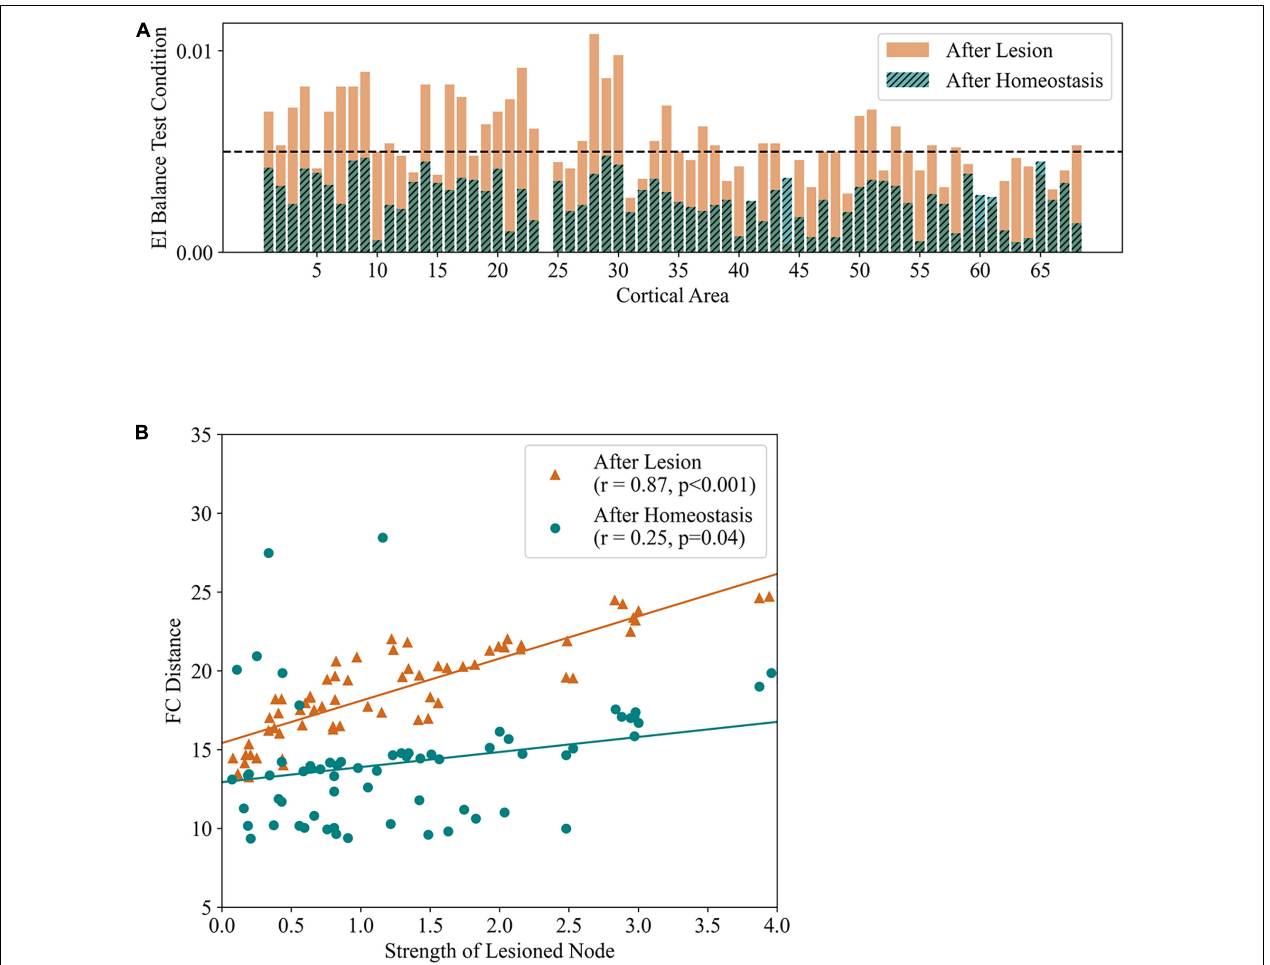
FIGURE 5 | EI homeostasis and recovery of FC cooccur in large-scale computational models of stroke. Results from the application of focal structural lesions in a large-scale model of the cortex with local EI homeostasis. (A) EI balance test condition measured immediately after lesion in the left precuneus and after homeostatic adaptation. Areas with values lower than 0.005 are considered balanced. It can be observed that EI balance is lost across the cortex immediately after lesion, being re-established by local homeostasis. (B) Correlation between the strength of lesioned nodes and differences in FC from baseline (FCD), immediately after lesion (black) and after restoring EI balance (black). Adapted from Vattikonda et al. (2016).